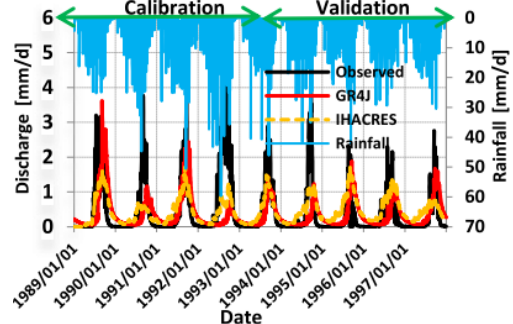
Figure 3. Models observed and simulated discharge between 1988 and